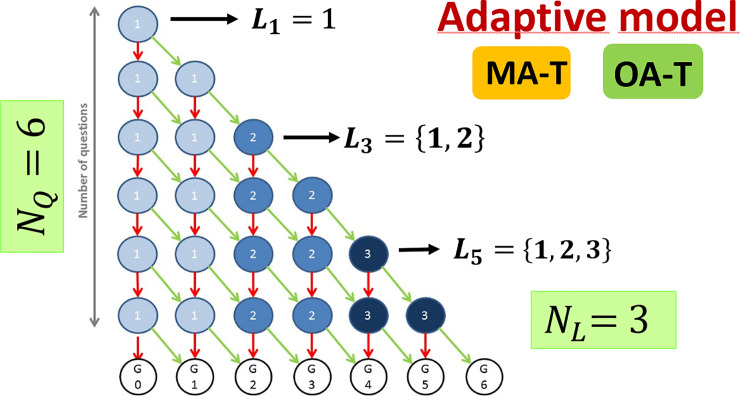
Representation of the CAT model.Green arrows indicate the path students take when they answer a question correctly. Students follow red arrows when an incorrect answer is given. Grades are represented at the bottom of the figure, improving with each step to the right.